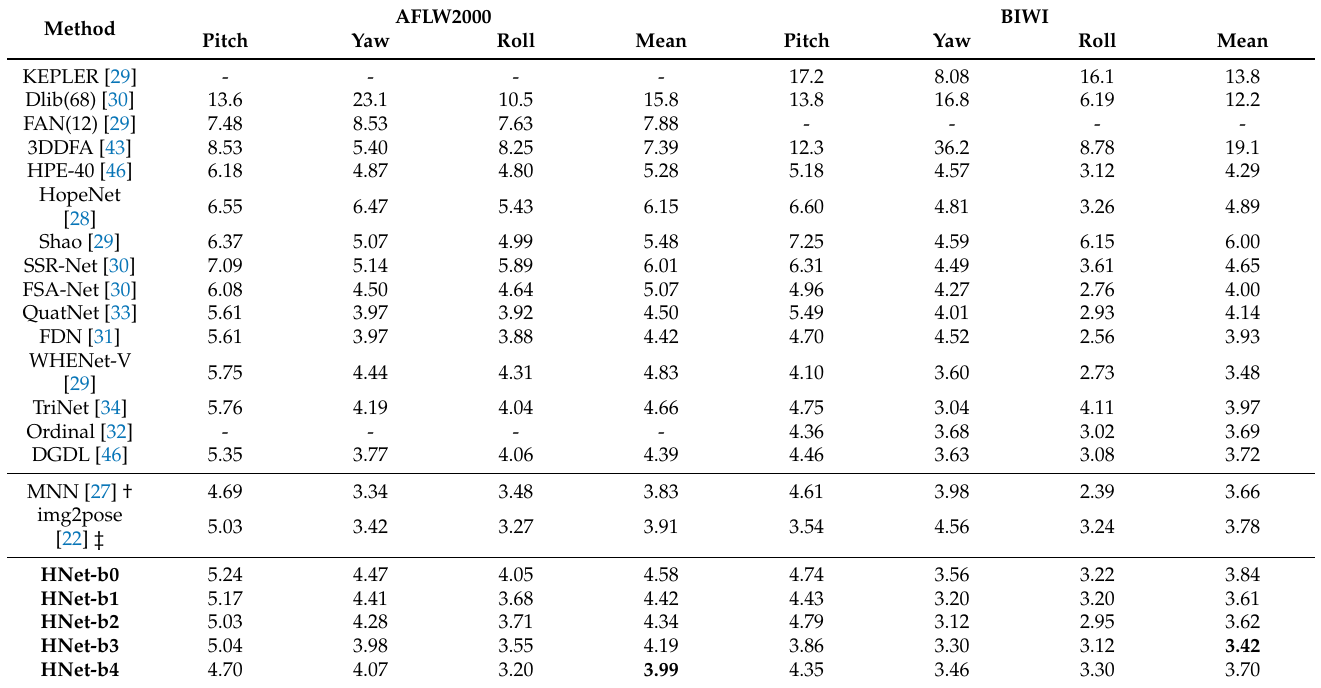
Table 1. A comparison of head pose estimation